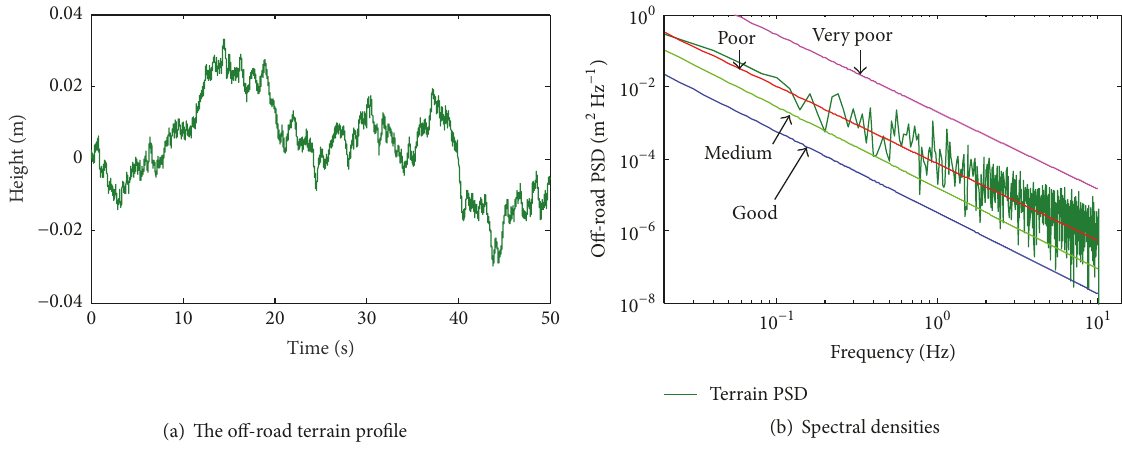
Figure 6: Generation of the off-road terrain roughness according to unpaved off-road classification.